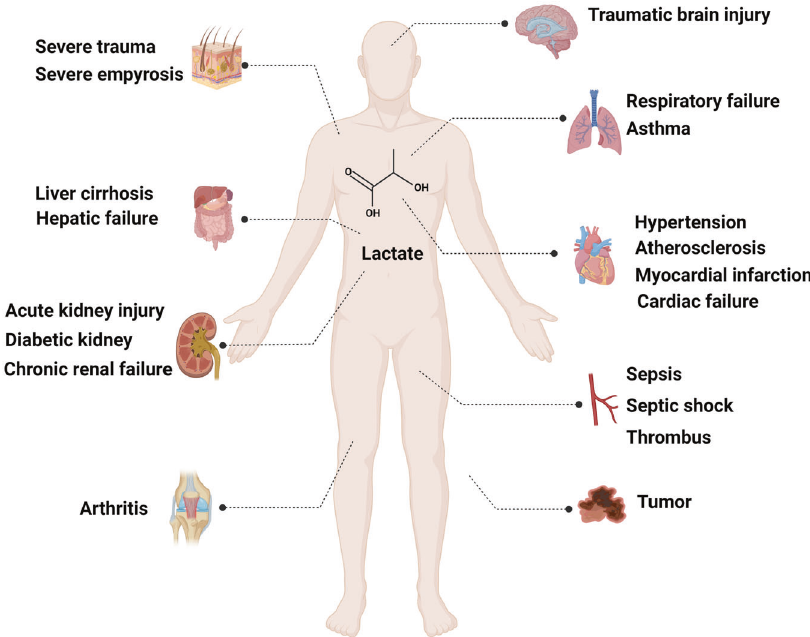
Fig. 4 Lactate contributes to various diseases. Lactate is involved in the regulation of cardiovascular system, respiratory system, digestive system, urinary system, and other diseases. Lactate plays an important role in clinical diagnosis and prognosis of diseases. (Figure was created with